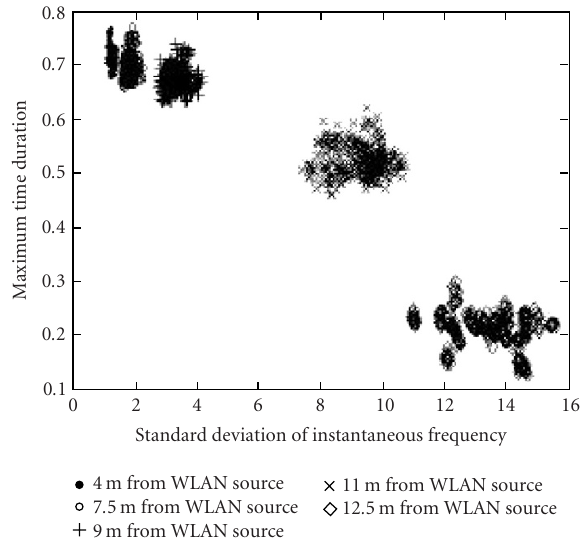
Figure 5: Feature plane at multiple-user positions for the WLAN + Bluetooth class by using